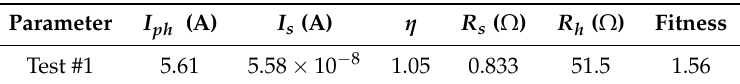
Table 4. Guess solutions for the SDM parameters in Test